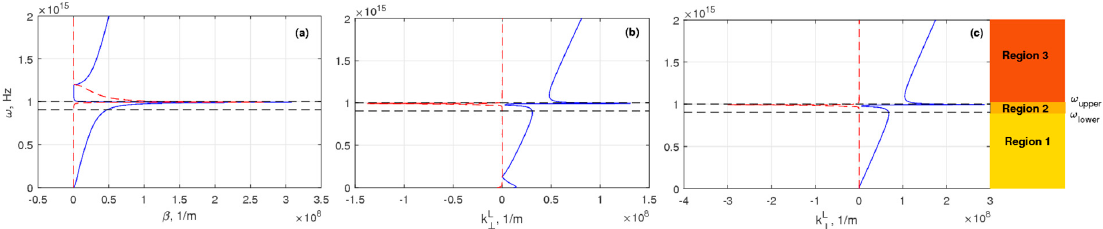
Figure 10. Each component of wavevector, when ε R = 18.8. The components of β ( a ) and k in both multilayered MMs ( b ) and free space ( c ).